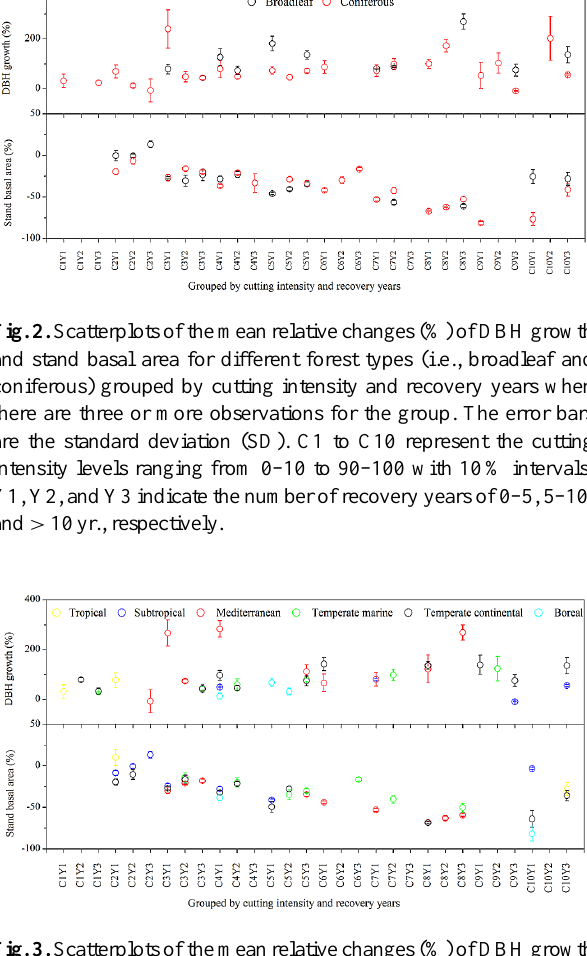
Fig. 3. Scatterplots of the mean relative changes (%) of DBH growth and stand basal area for different climatic zones (i.e., tropical, sub- tropical, Mediterranean, temperate marine, temperate continental, and boreal) grouped by cutting intensity and recovery years when there are three or more observations for the